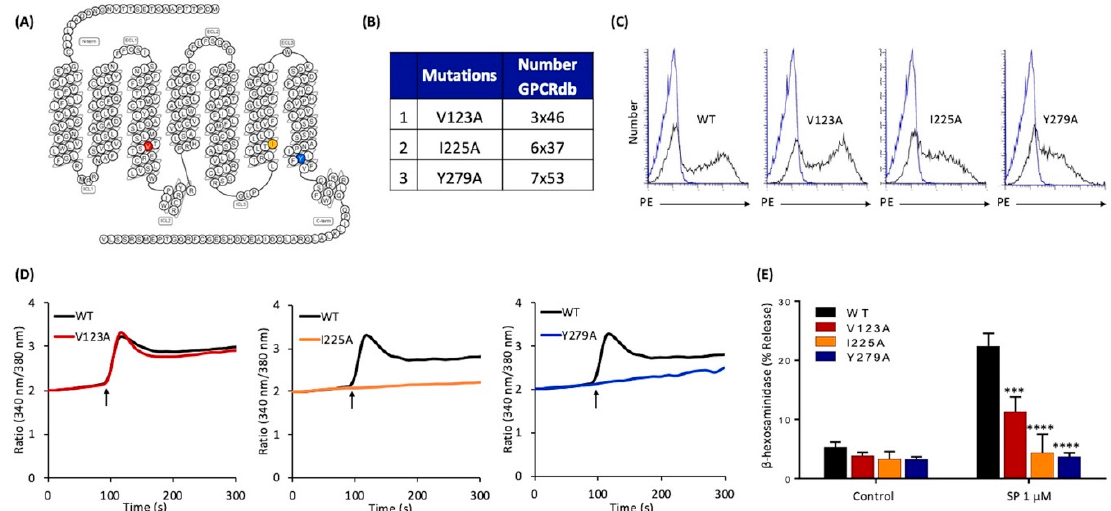
Figure 2. E ff ects of mutations at MRGPRX2’s highly conserved positions within transmembrane domains (V123A, I225A, and Y279A) on cell surface expression, SP-induced Ca 2 + mobilization, and degranulation in transiently transfected RBL-2H3 cells. ( A ) Snake diagram of secondary structure of MRGPRX2. Each circle represents amino acid residue with one letter code. Solid red, yellow, and blue backgrounds denote the residues at positions 3x46 (V123), 6x37 (I225), and 7x53 (Y279), respectively; ( B ) amino acid change for each MRGPRX2 mutant.; ( C ) RBL-2H3 cells transiently expressing wild-type (WT)-MRGPRX2 and its mutants were incubated with phycoerythrin (PE)-anti-MRGPRX2 antibody and cell surface receptor expression was determined by flow cytometry. Representative histograms for WT / mutant (black line) and control untransfected cells (blue line) are shown; ( D ) cells expressing WT-MRGPRX2 and its mutants were loaded with Fura-2 and intracellular Ca 2 + mobilization in response to SP (1 µ M) was determined. Data shown are representative of three independent experiments; ( E ) cells were exposed to a bu ff er (control) or SP (1 µ M) for 30 min, and β -hexosaminidase release was determined. All data points are the mean ± SEM of at least three experiments performed in triplicate. Statistical significance was determined by a nonparametric t -test. *** p ≤ 0.001 and **** p ≤